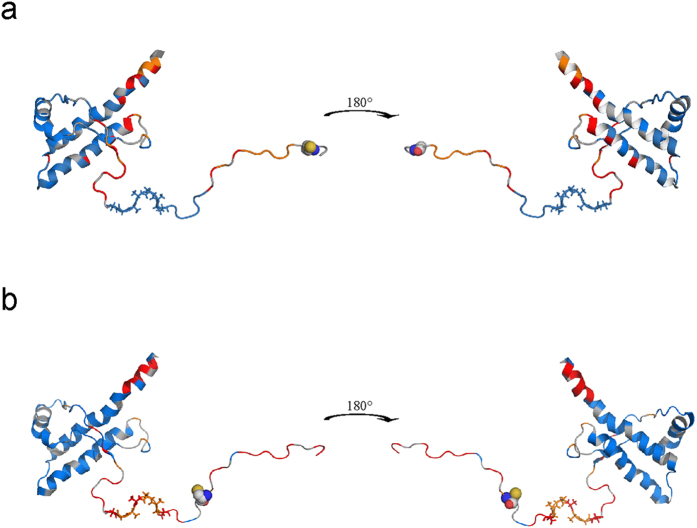
Mapping of paramagnetic effects on spin labeled full-length prion protein.Paramagnetic effects of MTSL and maleimide-linked nitroxyl spin label on huPrP variants G93C (a) and T107C (b), respectively. Very strong paramagnetic effects > 2 σ0 are colored in orange, strong effects > σ0 in red, small and negative effects < σ0 are colored in blue and unassigned residues in grey. The labeling position is displayed as spheres and the alanine-rich region in sticks. Mapping of the paramagnetic effects and in silico mutagenesis was done with Pymol (Schrödinger LLC) and the first structure of PDB entry 2KUN.